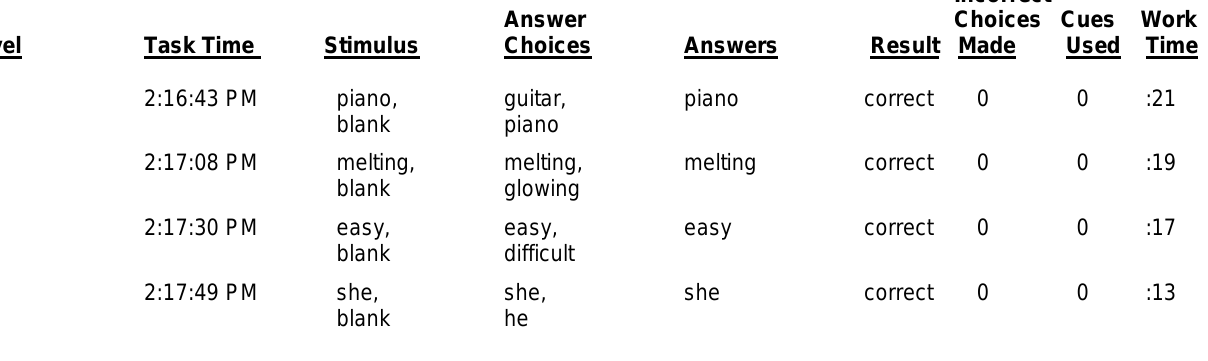
Table 8. On-Line Activity Log Data (illustrative samples)